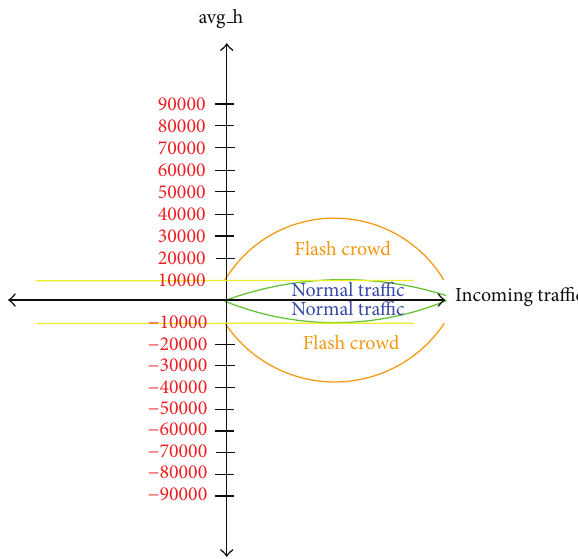
Figure 5: Clicks’ average of the hot web